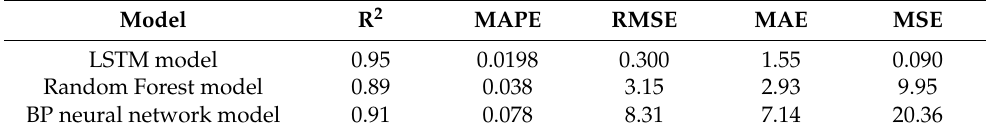
Table 5. Comparison of prediction results of prediction